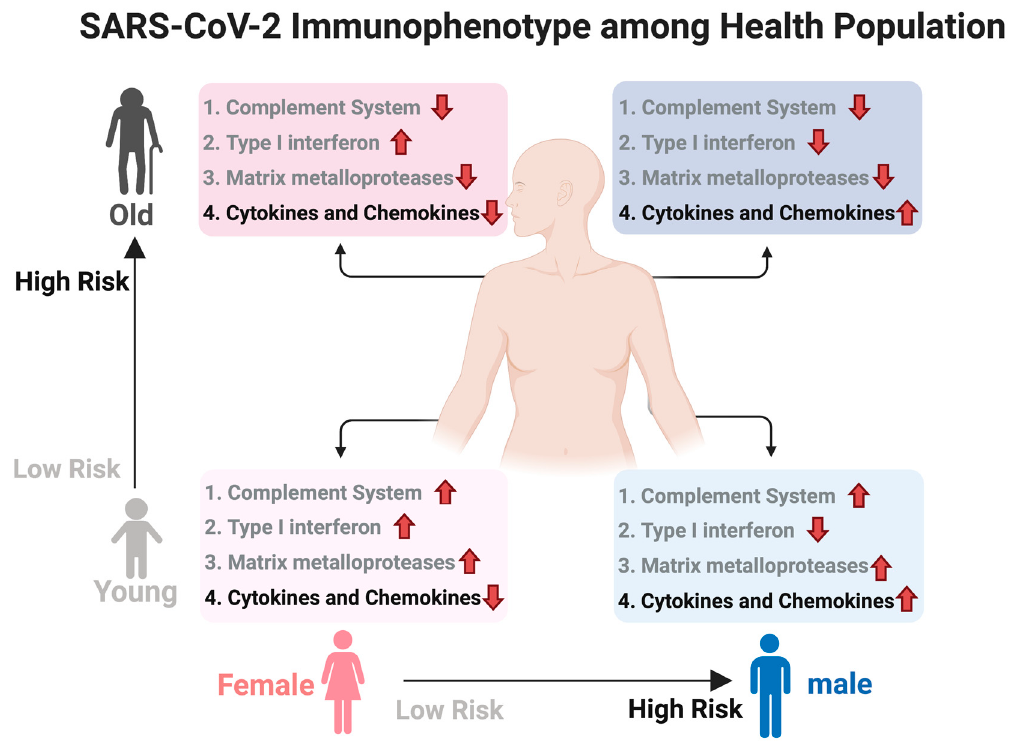
Figure 7. Summary of immunophenotype differences among demographic groups relevant to COVID-19 . Different groups have a distinct basal immunophenotype that may contribute to their different clinical outcomes when infected with SARS-CoV-2. Here old is considered an age higher than 60 y. The direction of the arrow indicates relative higher (up) or lower (down) expression for that group of genes. Groups 1–3 have a protective role while group 4 associated to higher susceptibility. Created with